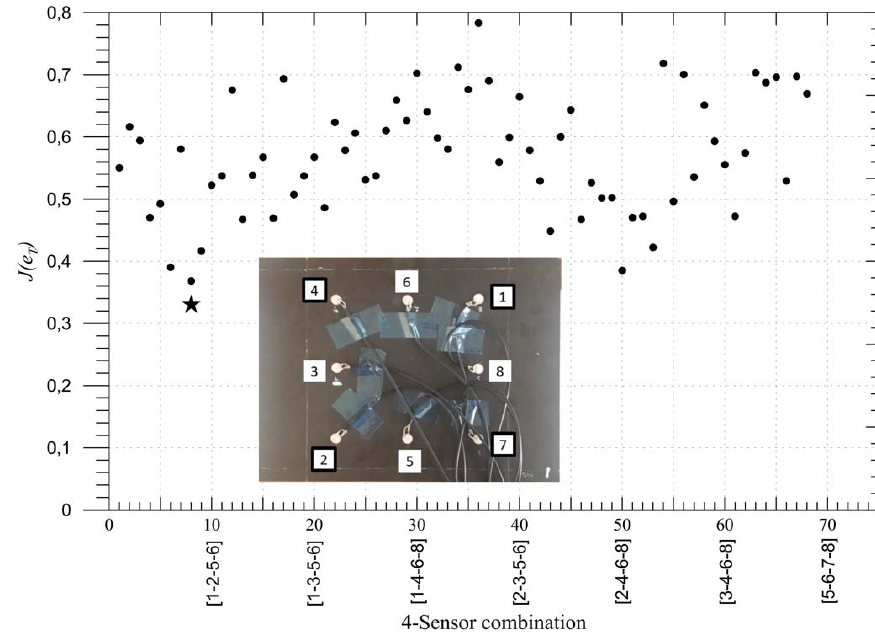
Figure 2. Fitness function J ( e T ) (given by Equation (7)) distribution for all the possible four-sensor combinations. J ( e T ) best = 0.33 ⇒ PoD =